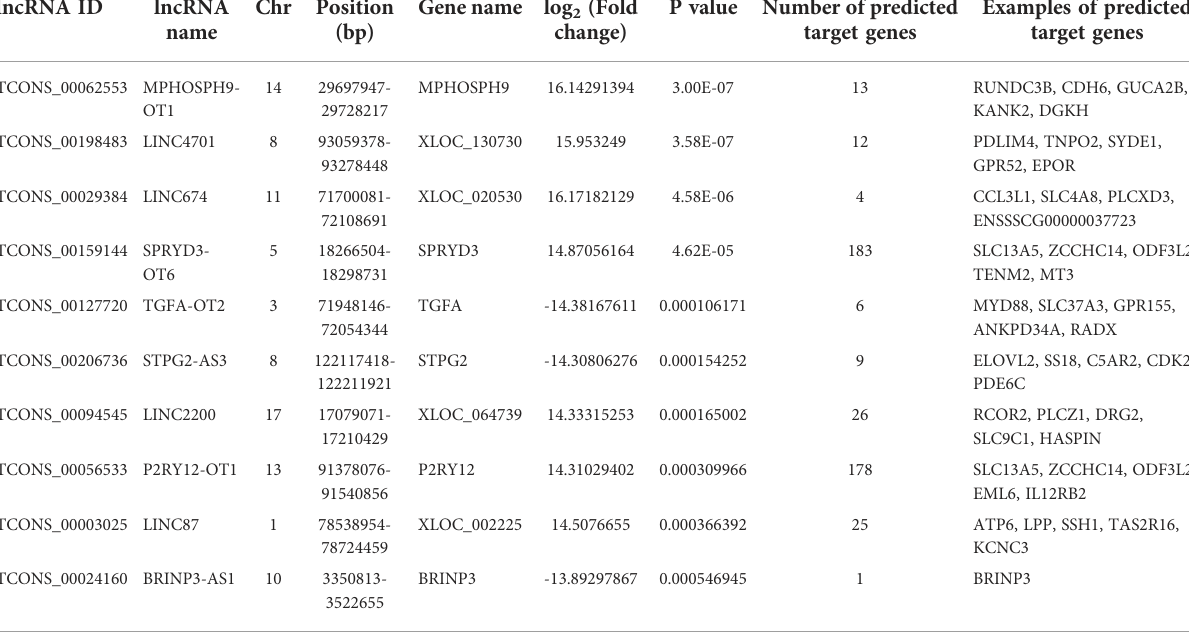
TABLE 2 Top 10 DE lncRNAs between ETEC-infected IPEC-J2 cells and wild-type cells. lncRNA ID